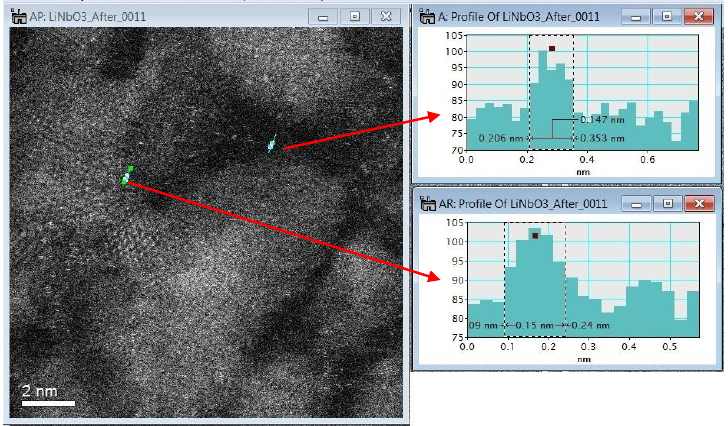
Figure 5. Dark field and bright field STEM image for LiNbO 3 with the heat treatment reduction at 650 °C; the measurements displayed correspond to single atoms of lithium and niobium, 0.155 nm and 0.147 nm, respectively, as measured using the Gatan ® DigitalMicrograph